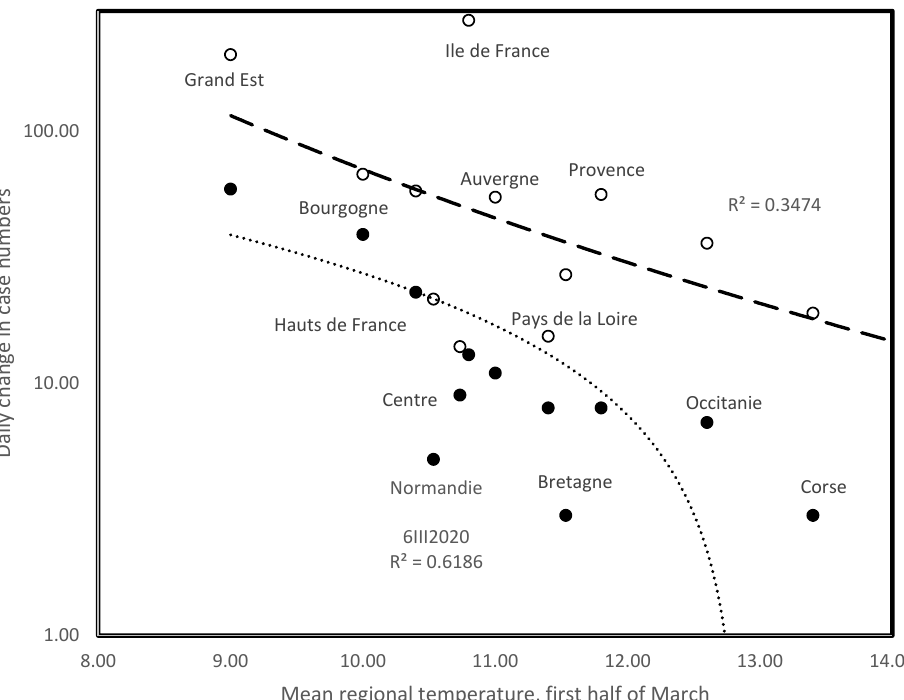
Figure 3. Daily increase in confirmed COVID-19 cases for administrative regions of France on 6 March 2020 (filled symbols, dotted line, log regression model) and on 15 March 2020 (circles, interrupted line, exponential regression model).